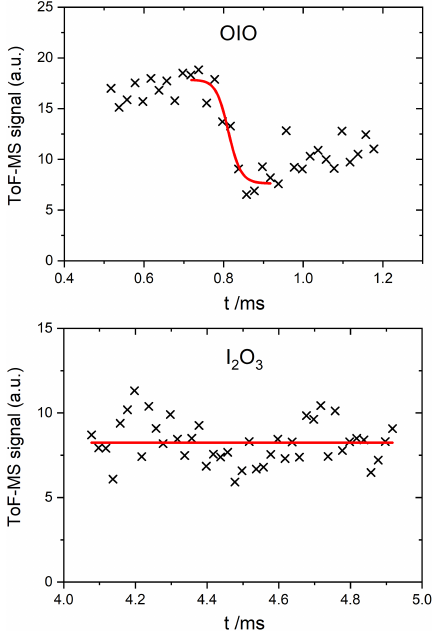
Figure 8. Measured photodepletion at 532nm of OIO and I 2 O 3 . The laser was triggered at 4.5ms in the I 2 O 3 experiment.